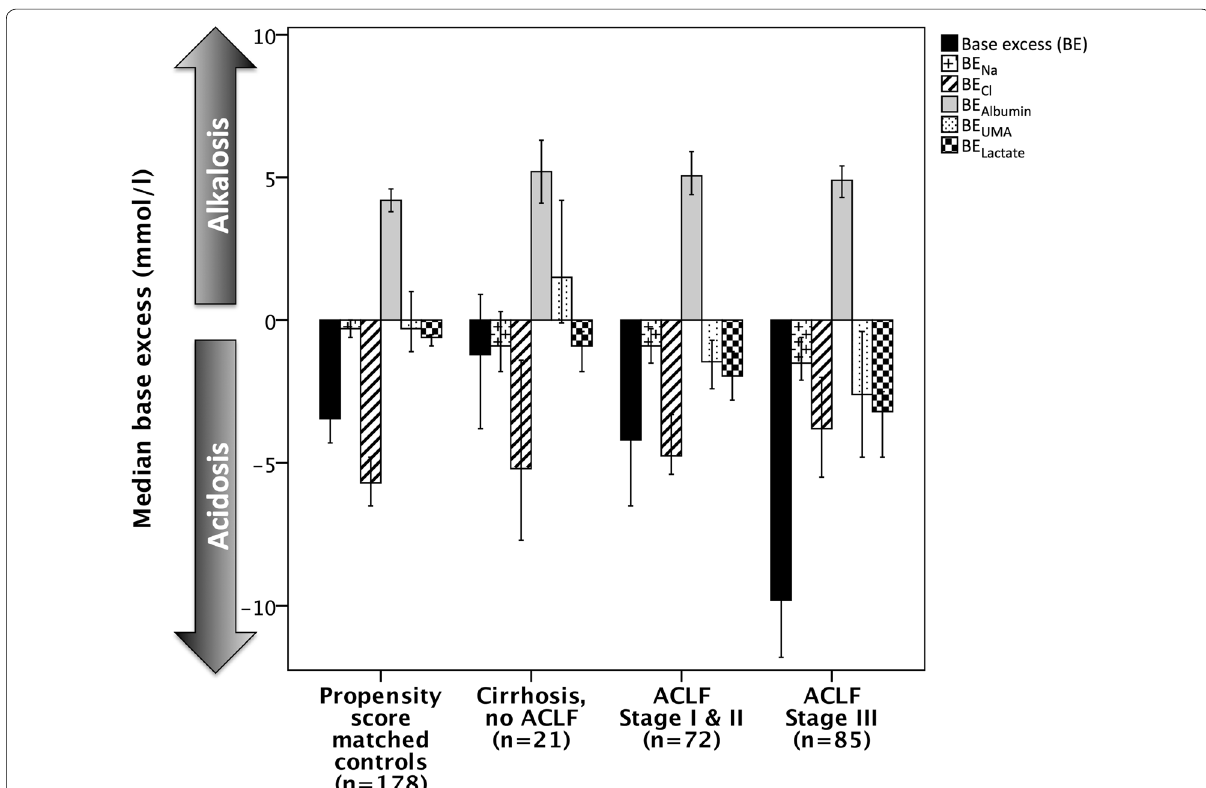
Fig. 1 Disequilibrium in acid–base status in critically ill patients with liver cirrhosis, acute‑on‑chronic liver failure (ACLF) and without chronic liver disease. Results displayed as median and 95% CI; associations of base excess and its subcomponents with ACLF stage in cirrhosis patients assessed by univariate ordinal regression: BE p < 0.001, BE Na p rhosis and control patients are illustrated in Table